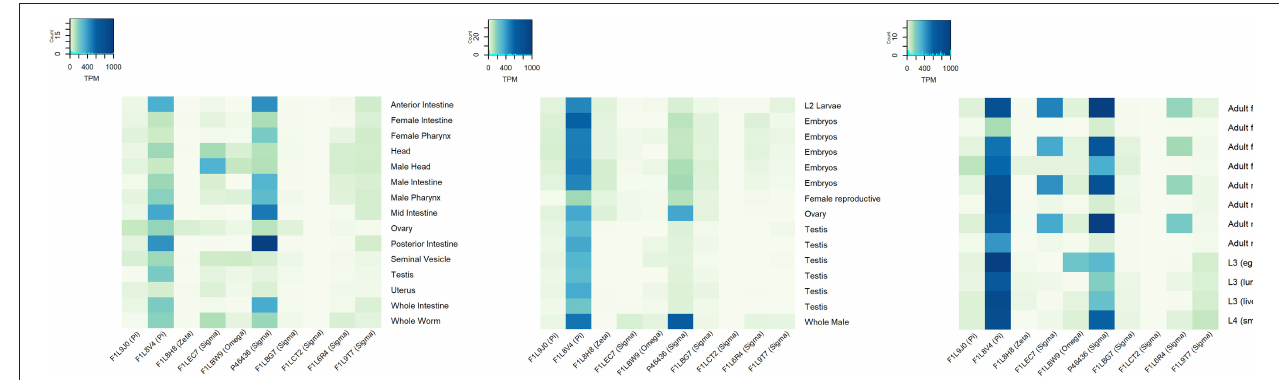
FIGURE 3 | Gene expression profile of GSTs from Ascaris suum based on public RNAseq data from experiments SRP013609 (left) , SRP005511 (middle) , and SRP010159 (left) . RNA expression levels in transcripts per million (TPM) in different tissues and lifecycle stages are showed (data from public RNA sequencing studies downloaded from